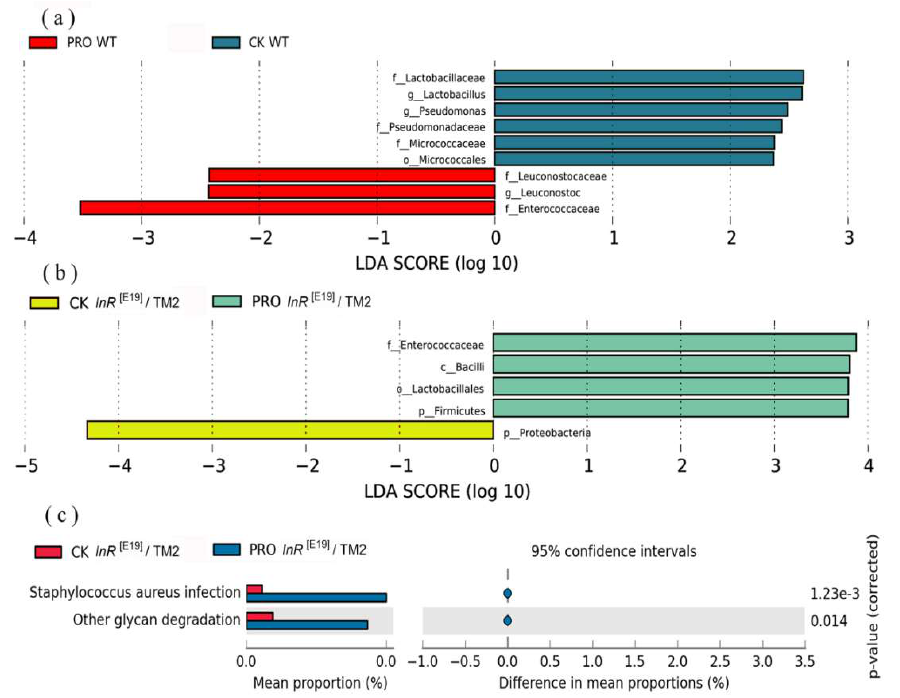
Figure 4. ( a ) Linear discriminant analysis (LDA) scores of the WT Drosophila on the probiotics-supplemented diet and the standard (CK) diet. ( b ) LDA scores of the InR [E19] /TM2 Drosophila on the probiotics-supplemented diet and the standard (CK) diet. ( c ) Changes in intestinal bacterial function in the CK InR [E19] /TM2 and PRO InR [E19] /TM2 groups ( p < 0.05).